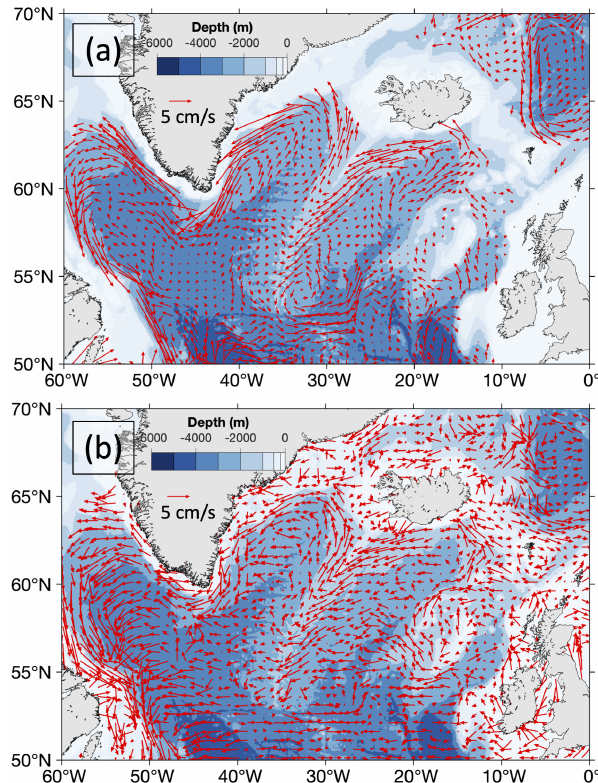
Figure 16. (a) Mean velocities at the 1000dbar pressure level based on Argo float trajectories and Argo profiles of temperature and salinity; (b) eddy propagation velocities calculated from satellite altimetry data. The velocities were computed for the time period of